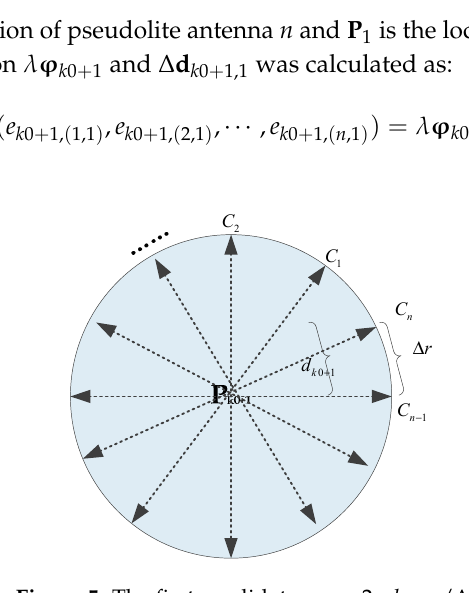
Figure 5. The first candidates, n = 2 π d k 0 + 1 / ∆ r .